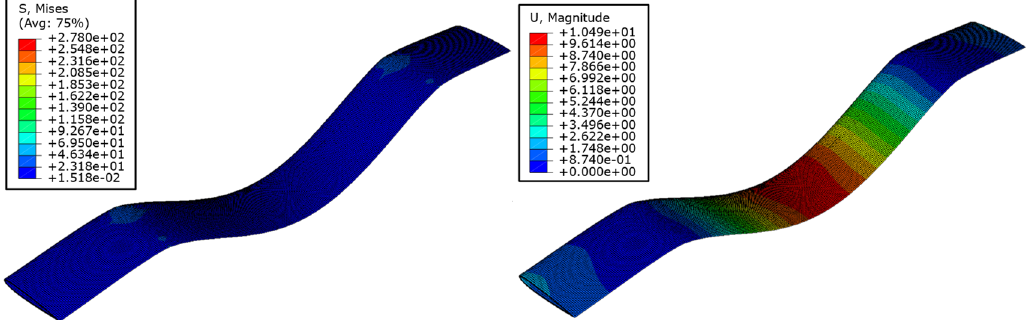
Figure 19. Von Mises stress S and displacements U with the optimal thickness of 5 mm of the V-Epoxy rotor blade 2 after the application of extreme loads.